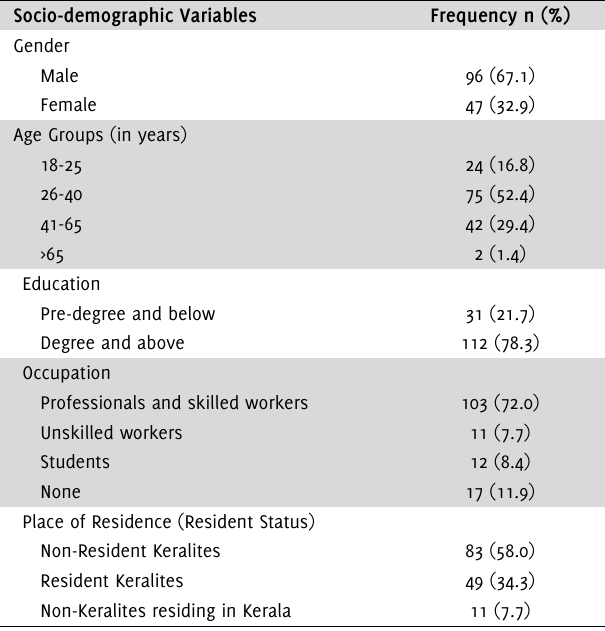
Table 1 . Socio-demographic characteristics of the study population (n =